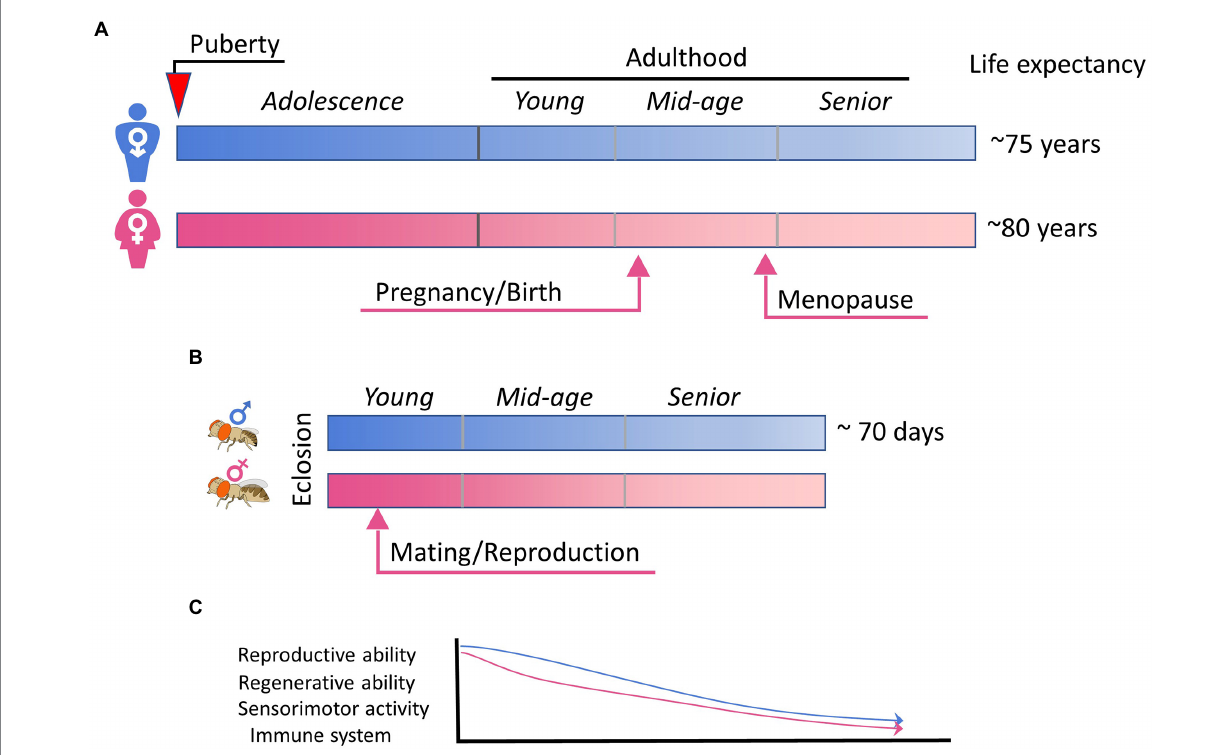
FIGURE 2 Aging and sex differences in human and fly. (A) A simplified summary of sex maturation, reproduction, and aging in human. Key events leading to physical, physiological, and hormonal changes in male and female are indicated arrows. (B) The schematic summary of the short lifespan of Drosophila flies, in which mating is known to trigger extensive changes in females. (C) A schematic plot highlighting the aging-associated functional declines that are common for human and fly, sexually dimorphic, and influenced by sex hormones and/or reproductive